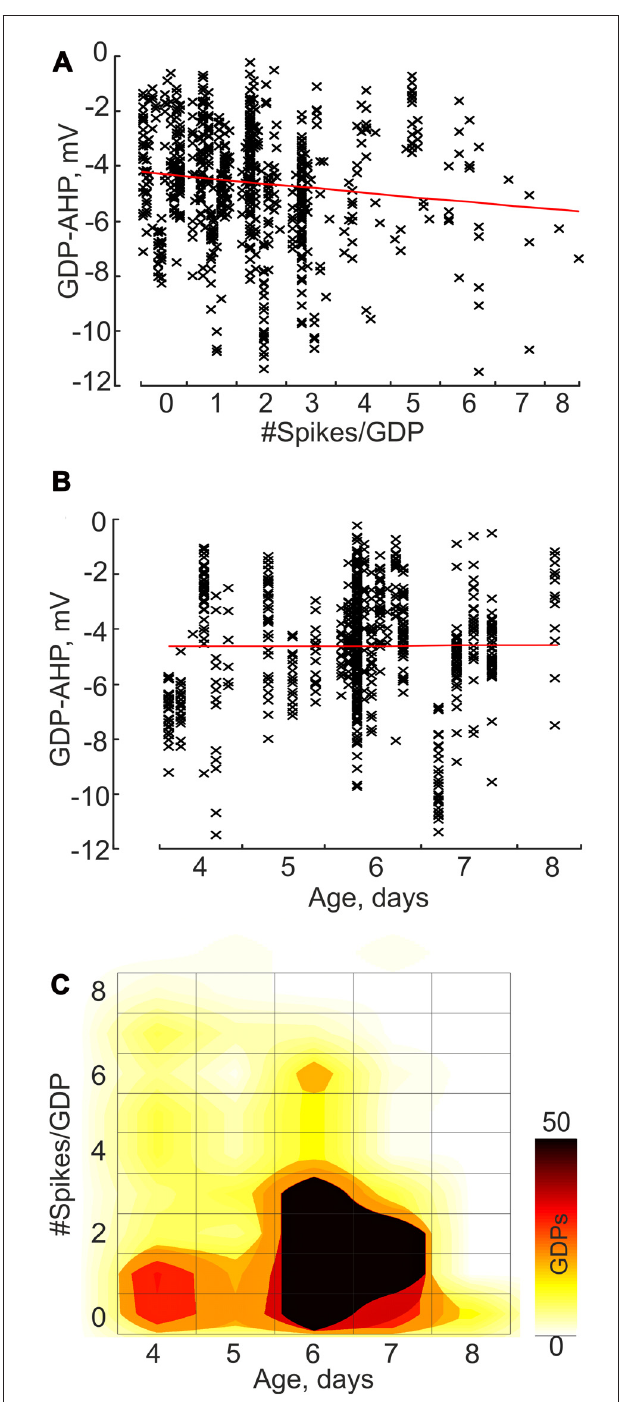
FIGURE 3 | Correlation between the GDP-AHP amplitude, cell firing during GDPs and age: group data. (A,B) GDP-AHP amplitude as a function of the number of spikes per GDP (A) and the animal age (B) . Each data point corresponds to an individual GDP and each column corresponds to an individual cell. Note an increase in the size of GDP-AHP with an increase in cell firing during GDP and no significant change in GDP-AHP size with age. (C) Color-coded dependence of cell firing during GDPs on age. (A–C) Group data obtained from 23 P4–8 CA3 pyramidal